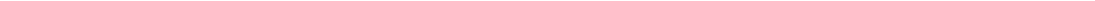
Fig. 6 Distinct regulation of early-switch exons in mature sensory neurons. a The PCA scatter plot of splicing pro fi les in different subtypes of neurons isolated from adult mice. The circles represent the cortex reference samples and the triangles represent the four categories of cell types: non-neuronal sensory receptors, sensory neurons, sensory ganglion neurons, and mature CNS neurons. Samples are colored by the predicted maturation stage. EC enterochromaf fi n cell, TRC taste receptor cell, OSN olfactory sensory neuron (OMP + ), DRG dorsal root ganglia sensory neurons (Nav1.8 + or Avil + ), DN dopaminergic neurons, CGN cerebellar granule neurons, PN Purkinje neurons, and MN motor neurons. b The splicing pro fi le of module exons in sensory neuron subtypes, in comparison with non-neuronal sensory receptor cells and mature CNS neurons. Exons are shown in the same order as in the cortex reference. c Statistically enriched GO terms of genes with differentially spliced exons between all sensory cell types and mature CNS neurons. The size and color represent the number and enrichment of genes associated with each term and related GO terms with overlapping genes are connected. d Expression levels of the four RBP families we focused on in our analysis as quanti fi ed by RNA-seq data. Note the high abundance of the Mbnl and Ptbp families and lack of Nova1/2 in sensory neurons. Rbfox1-3 are absent or low in sensory neurons, but expressed in ganglion neurons. e Immuno fl uorescence analysis of Rbfox1-3 expression in OSNs. Red, Calmegin is a marker of mature OSNs; green, Rbfox; blue, DAPI staining the DNA. Scale bar, 20 μ m. f Maturation stages of different types of neurons predicted using the overall splicing pro fi le or target exons of each RBP family. g The proposed model that explains the distinct splicing pro fi les of different neuronal